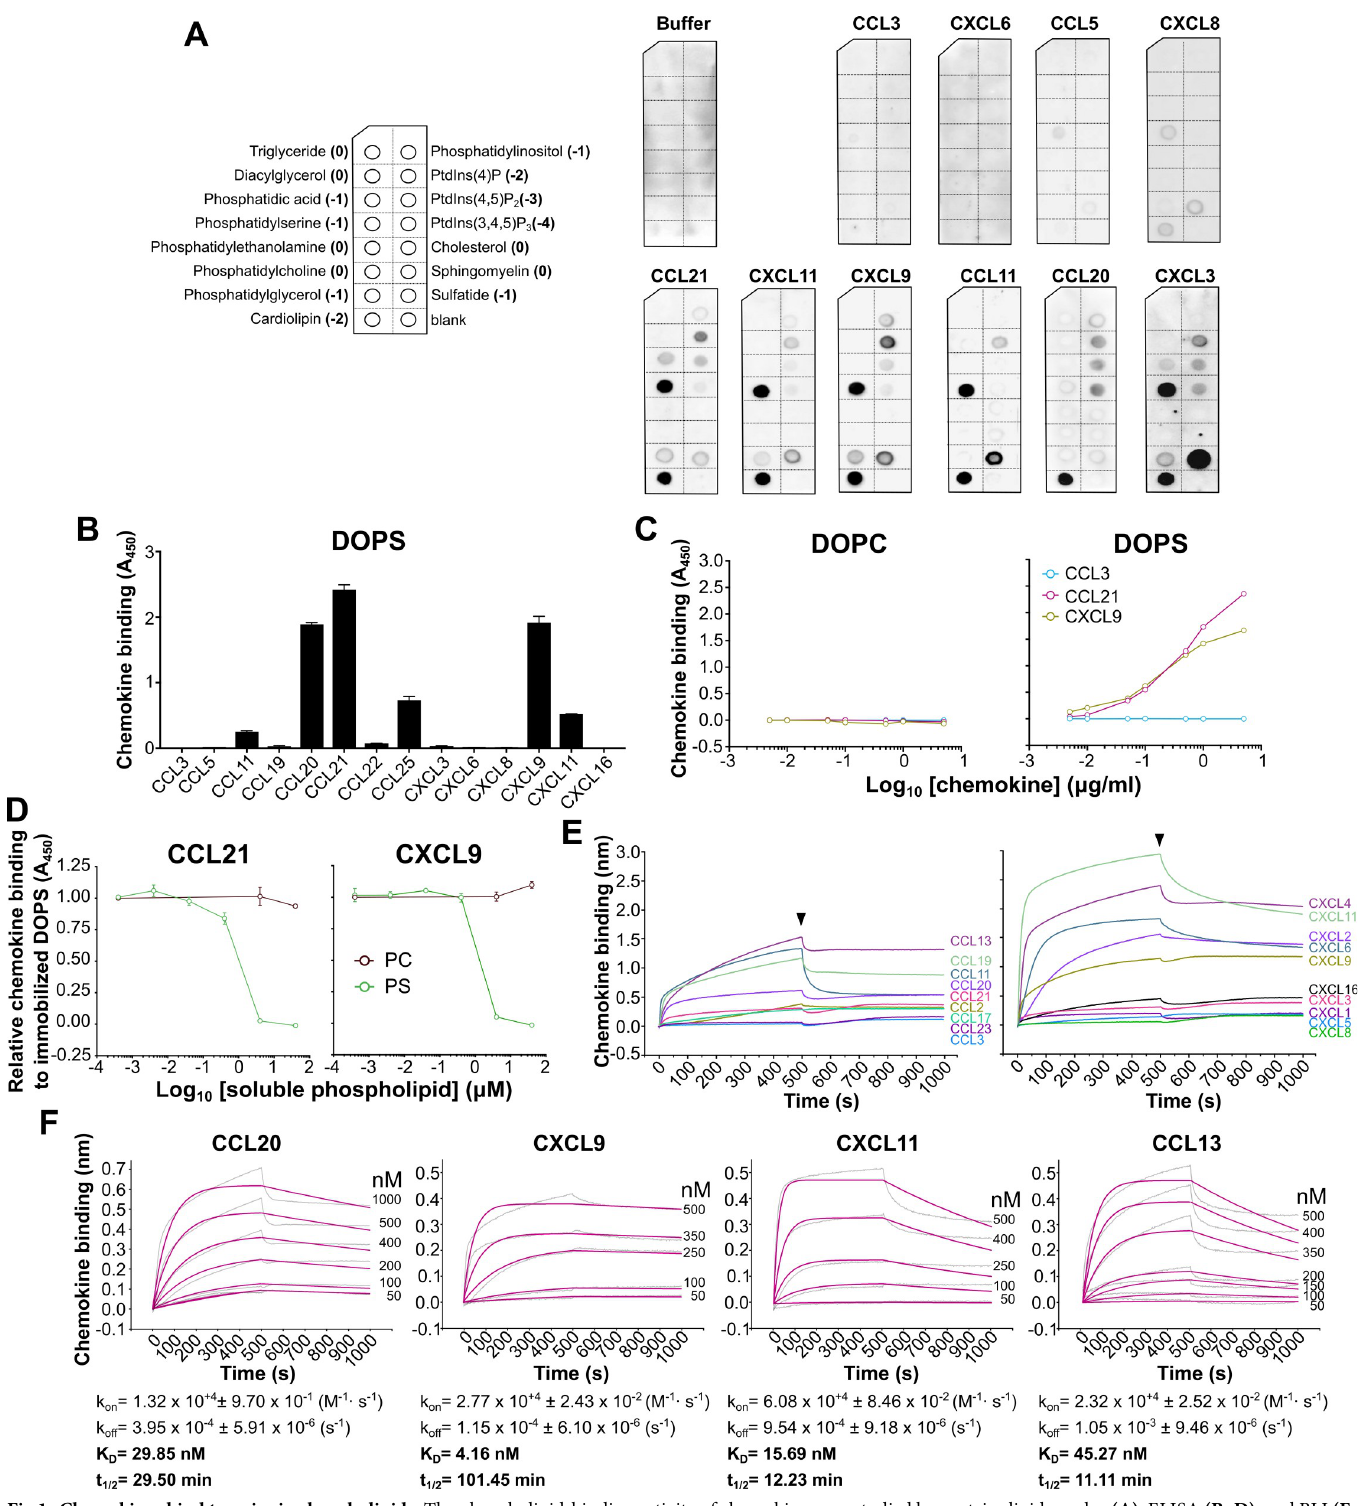
Fig 1. Chemokines bind to anionic phospholipids. The phospholipid-binding activity of chemokines was studied by protein–lipid overlay (A) , ELISA (B–D) , and BLI (E, F) . (A) Arrays spotted with 15 different phospholipids (left panel; in parentheses, net charge of each phospholipid) were incubated with buffer or 0.1 μ g/ml of the